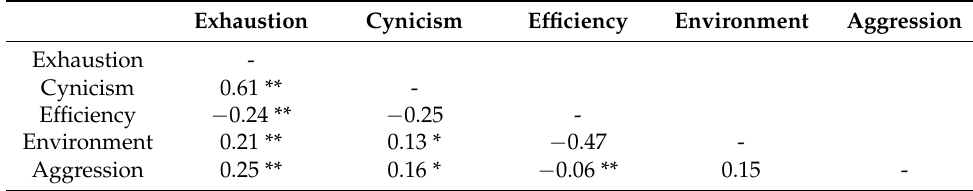
Table 6. Correlational analysis of study variables. Exhaustion Cynicism Efficiency Environment